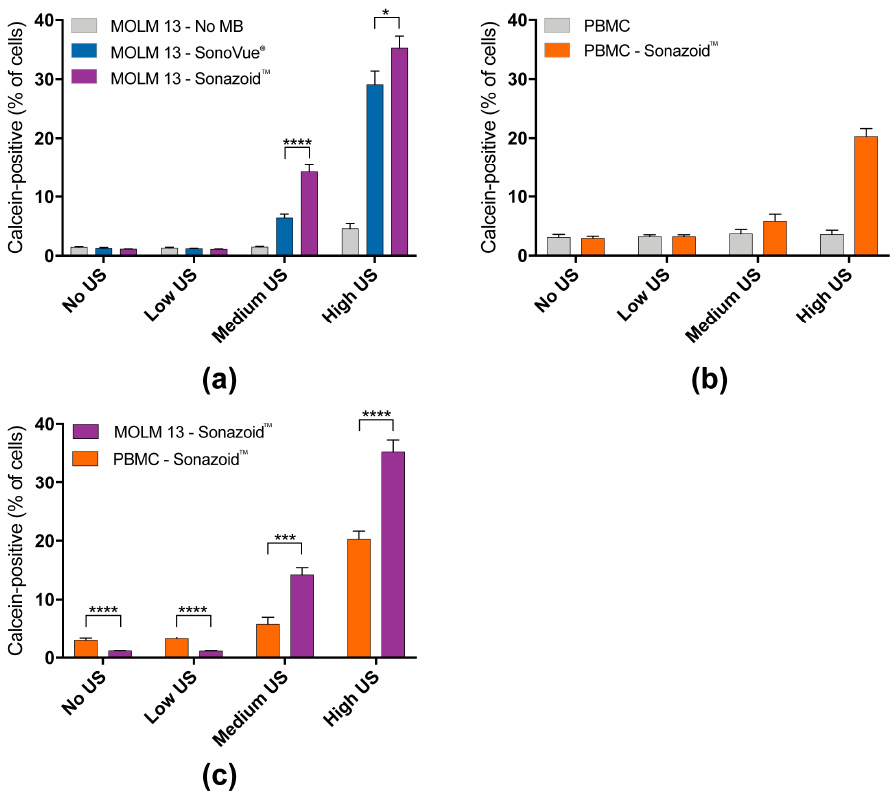
Figure 2. Increasing the ultrasound intensity and the addition of microbubbles significantly increased the percentage of calcein-positive cells. ( a ) Percentage of calcein-positive MOLM-13 cells versus ultrasound intensity. Increasing the ultrasound intensity correlated to an increase in calcein positive cells. The addition of microbubbles significantly increased the calcein-positive